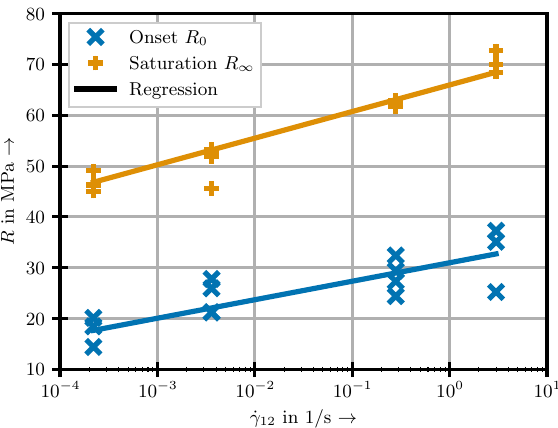
Figure 12. Summary of the onset and saturation points of significant nonlinearity for the 12- configuration.